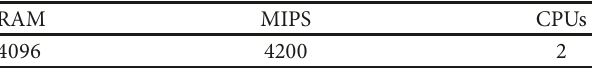
Table 2: Simulation